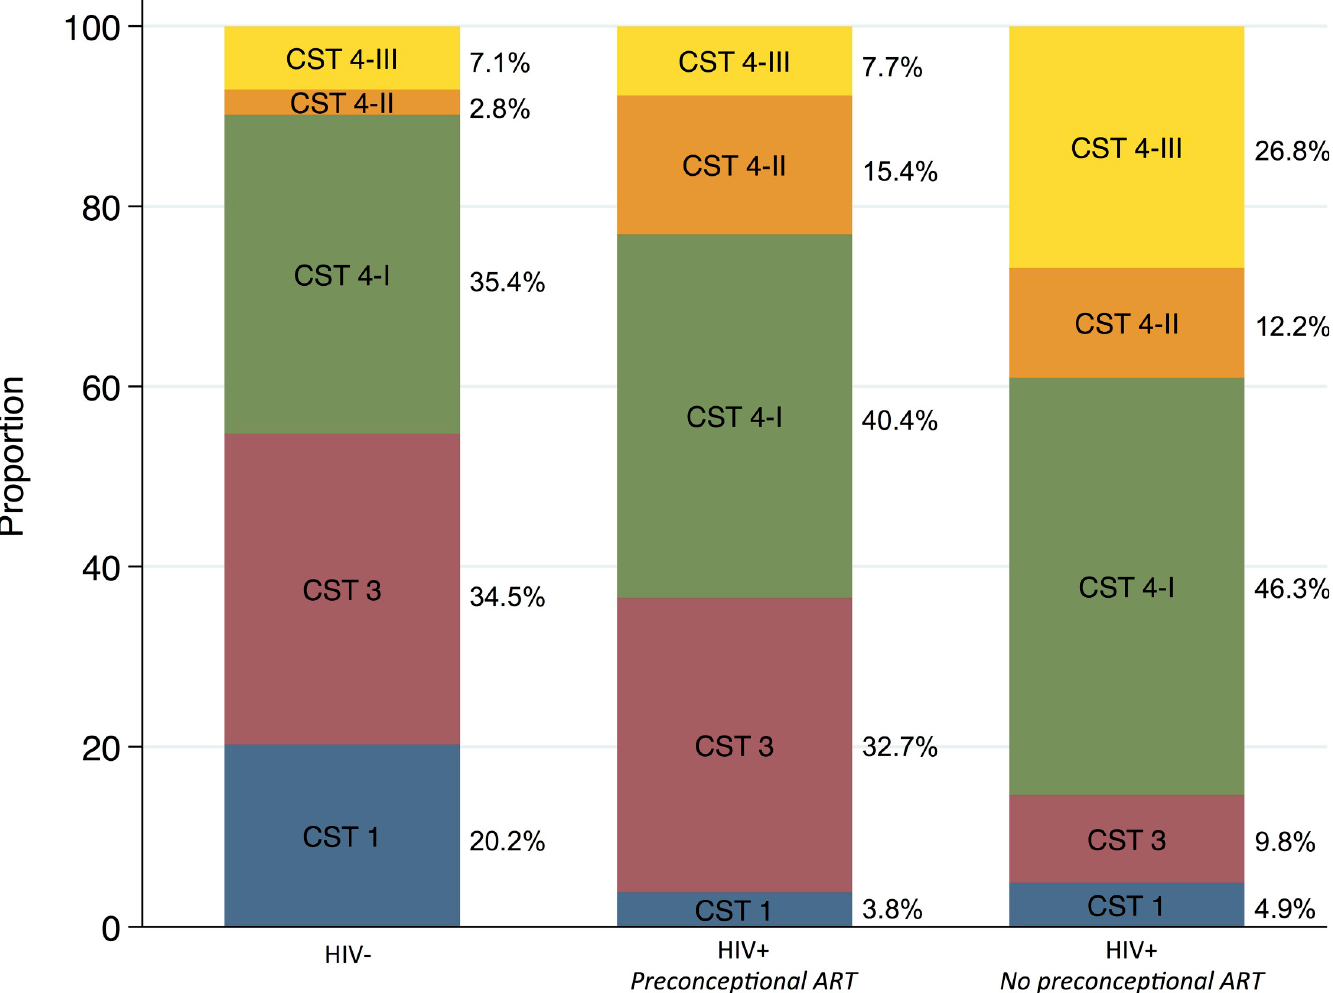
Fig 5. Prevalence of community state types by HIV serostatus and timing of initiation of antiretroviral therapy in ZAPPS. Anaerobe-dominant community state types were most prevalent among HIV-infected participants, both with and without preconceptional ART exposure. Comparing Lactobacillus -dominated CSTs only, HIV-infected participants with preconceptional ART exposure had higher relative abundance of CST 3 over CST 1 compared to uninfected participants. CST, community state type; ART, antiretroviral therapy.